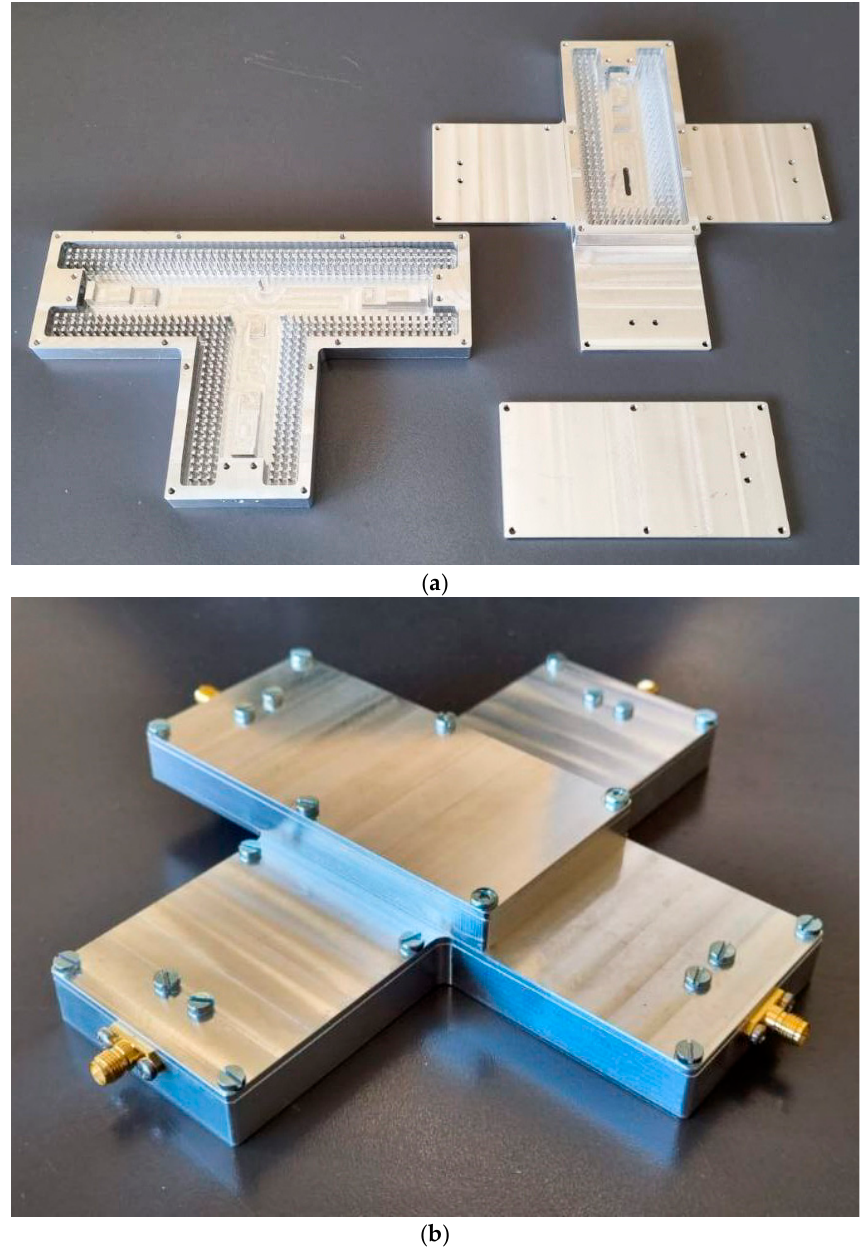
Figure 12. Manufactured X-shaped magic-T. ( a ) Separate layers. ( b ) Assembled prototype.